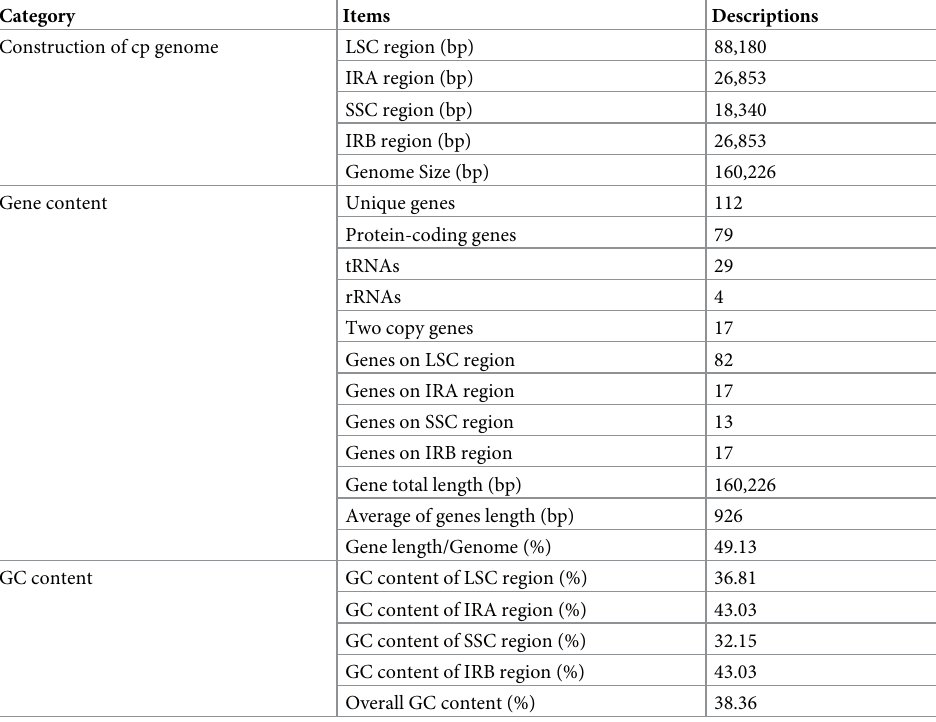
Table 1. The detail features of the complete cp genome of H . cordata